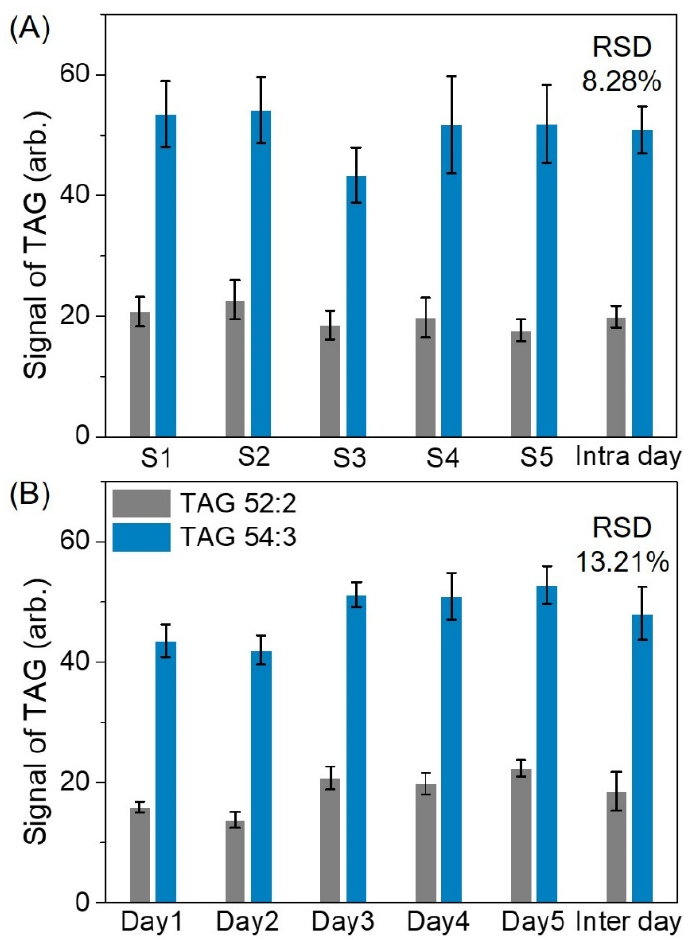
Figure 3. Ion intensity and error bar in the TAG signals obtained using ( A ) five samples within 1 day and ( B ) five repeated experiments in an individual day. The average intra-sample RSD was 11.95% (S1), 12.26% (S2), 11.80% (S3), 16.23% (S4), and 12.36% (S5). The average intra-day RSD was 5.82% (Day 1), 7.76% (Day 2), 6.60% (Day 3), 8.28% (Day 4), and 6.03% (Day 5). The average inter-day RSD was 13.21%. Each data bar represents the sum of 200 laser shots. Error bars represent the standard errors of 5 repeated experiments, including the average of 5 SALDI samples for each experiment, 25 spots from each sample, and 20 laser shots at each sample spot. Gray bars represent TAG 52:2—RSDs of the TAG 52:2 signal: 11.81% (S1), 14.35% (S2), 12.98% (S3), 16.81% (S4), 10.29% (S5), 5.52% (Day 1), 9.72% (Day 2), 9.18% (Day 3), 8.89% (Day 4), and 6.08% (Day 5). Blue bars represent TAG 54:3—RSDs of the TAG 54:3 signal: 10.14% (S1), 10.17% (S2), 10.62% (S3), 15.64% (S4), 12.42% (S5), 6.12% (Day 1), 5.80% (Day 2), 4.05% (Day 3), 7.66% (Day 4), and 9.20% (Day